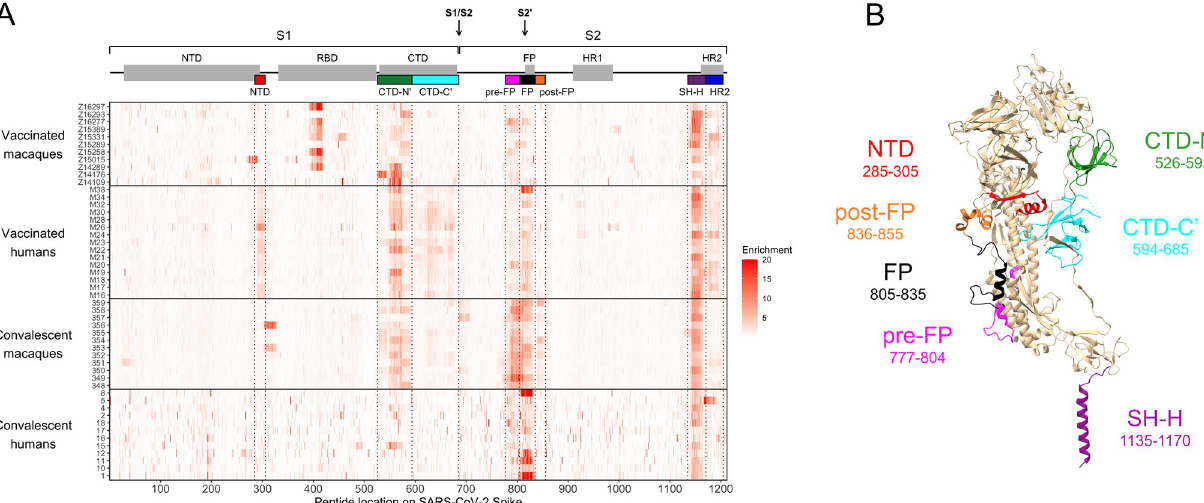
Fig 1. Enrichment of wildtype peptides. (A) The x axis indicates each peptide’s location along SARS-CoV-2 Spike protein, and each entry on the y axis is an individual sample. All enrichment values over 20 are plotted as 20 to better show the lower range of the data. Above the heatmap, domains of Spike are shown with grey boxes, with the S1/S2 and S2’ cleavage sites indicated with arrows. The epitope regions defined in the current study are shown as colored boxes (from left to right: NTD in red, CTD-N’ in green, CTD-C’ in cyan, pre-FP in pink, FP in black, post-FP in orange, SH-H in purple, and HR2 in blue). (B) Defined epitope regions shown on a structure of one monomer of SARS-CoV-2 Spike in the pre-fusion conformation (PDB 6XR8 [ref 95]). The amino acid loci spanned by each epitope are listed. The HR2 epitope (AA 1171–1204) could not be resolved on the structure and is not